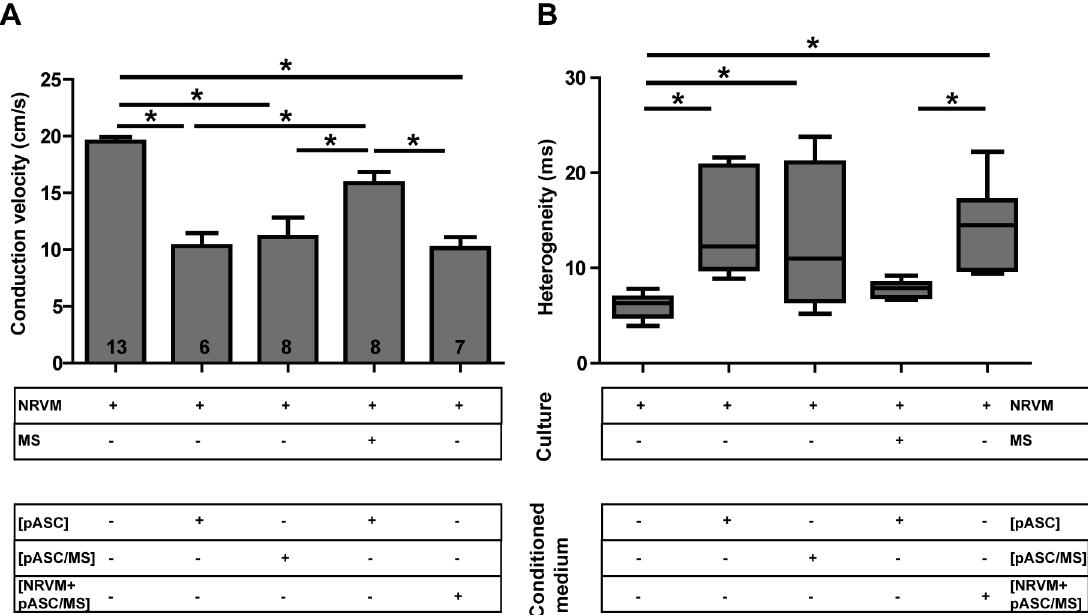
Fig 6. Effects of conditioned medium. The effects on A: conductionvelocity and B: conductionheterogeneity of monolayers of NRVM cultured in variousconditioned mediums. * indicatesp (cid:20) 0.05. Number of replicatesper experimental conditionis indicatedin the bar-graphs. Abbreviations; Cme: conditioned medium, MS: microspheres, NRVM: neonatalrat ventricular myocytes and pASC: porcine adiposetissue-derived stromal cells. See text for details.